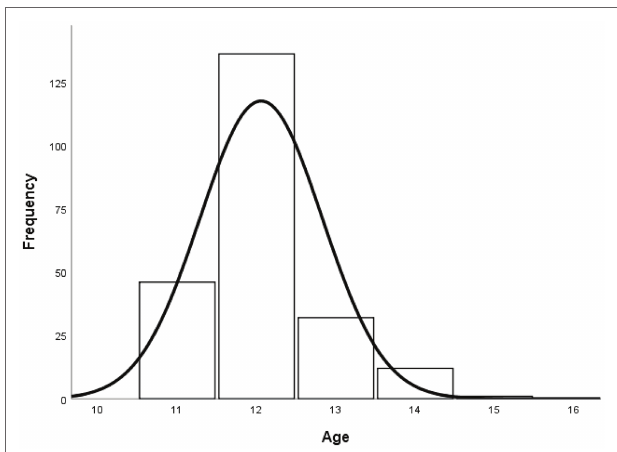
FIGURE 1 | Distribution of students by